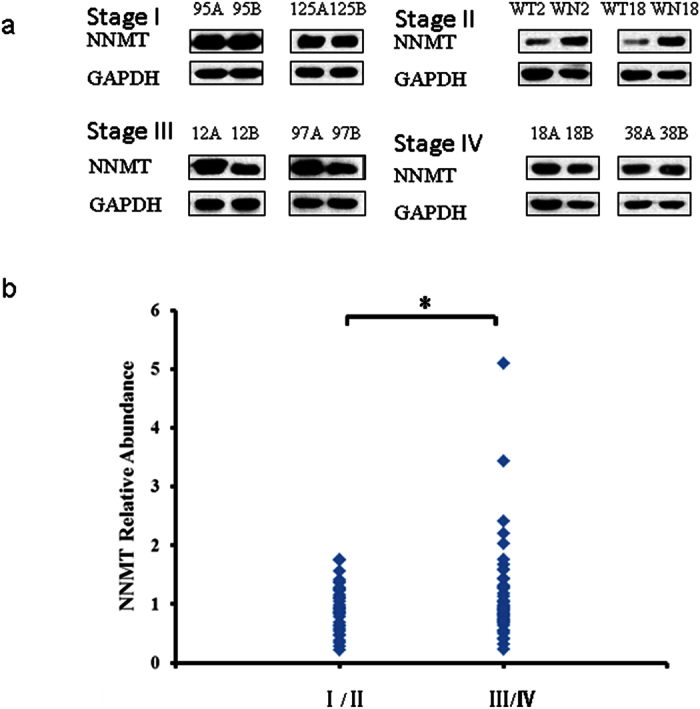
Validation of NNMT expression by Western Blot.(a) Representative Western Blot image of NNMT expression in stages I–IV GC samples (A or WT. cancer, B or WN. normal gastric tissue). The blots were cropped and full length blots are presented in Supplementary Figure S4. (b) NNMT relative abundance in 97 GC samples. *P < 0.05.